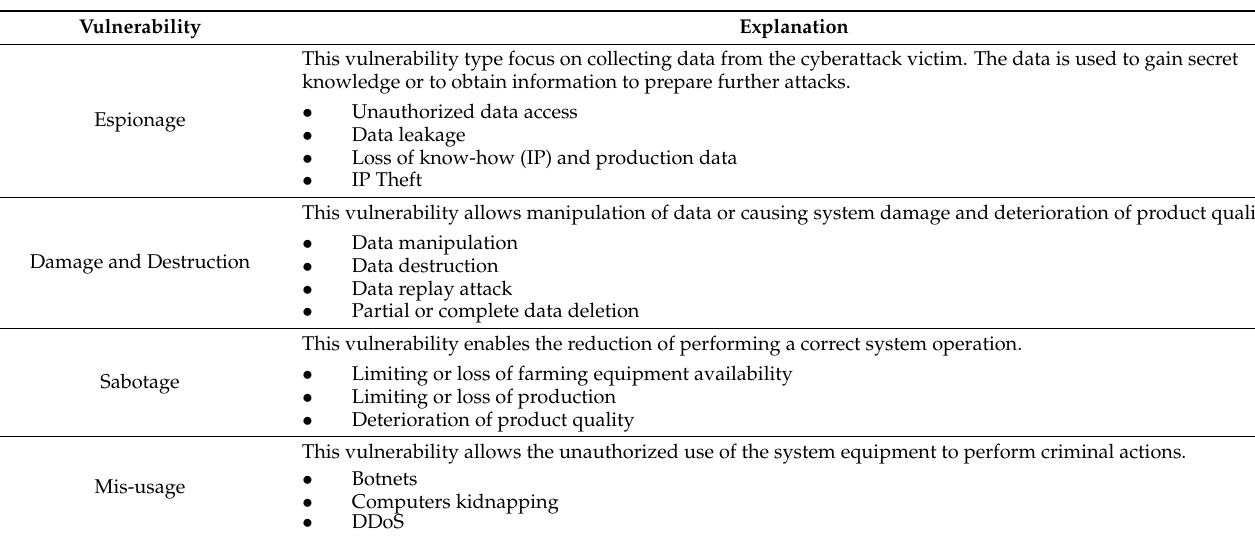
Table 3. Cybersecurity: security